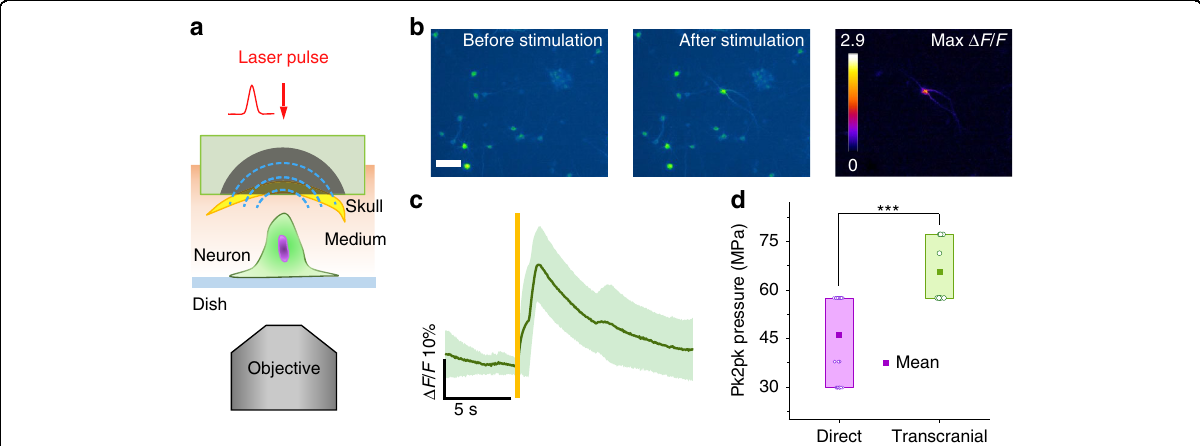
Fig. 4 Transcranial stimulation by OFUS in vitro. a The schematic of transcranial in vitro stimulation. b Representative images of neurons before and after transcranial stimulation. The rightest panel showed the maximum Δ F/F. Scale bar: 50 μ m. c The averaged calcium response trace of transcranial OFUS stimulation. Yellow vertical line: laser on. The average trace in solid and SEM in shades. d Statistics of threshold pressure of direct and transcranial stimulation with a single cycle. *** p <